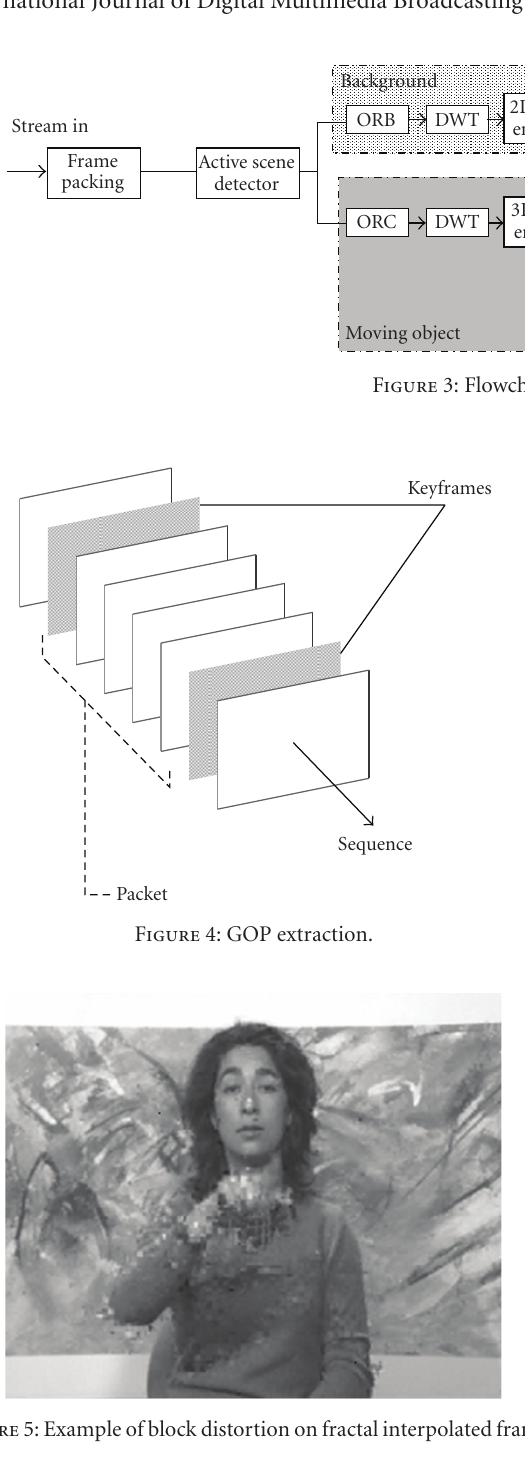
At decoding time, the inverse process is applied, and the fractal zoom is performed. An Ordered Cube Overlapping (OCO) postprocess, defined as an extension of Ordered Square Overlapping (OSO) [12], merges the parts created by the overlapped partition of three-dimensional fractal code.